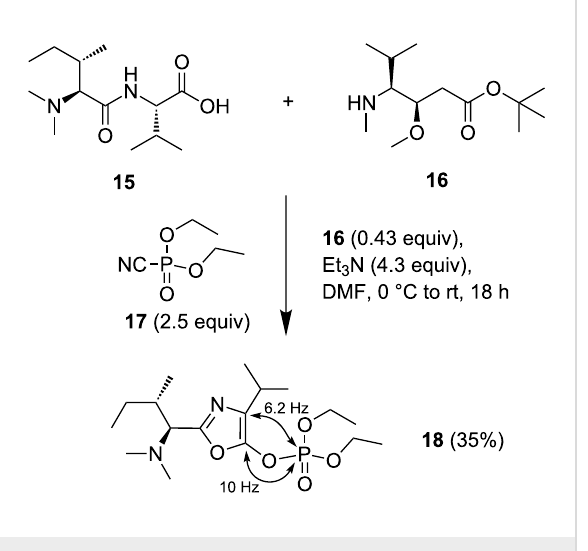
Scheme 2: Formation of oxazolylphosphate 18 on attempted DEPC- mediated coupling of dipeptide 15 .